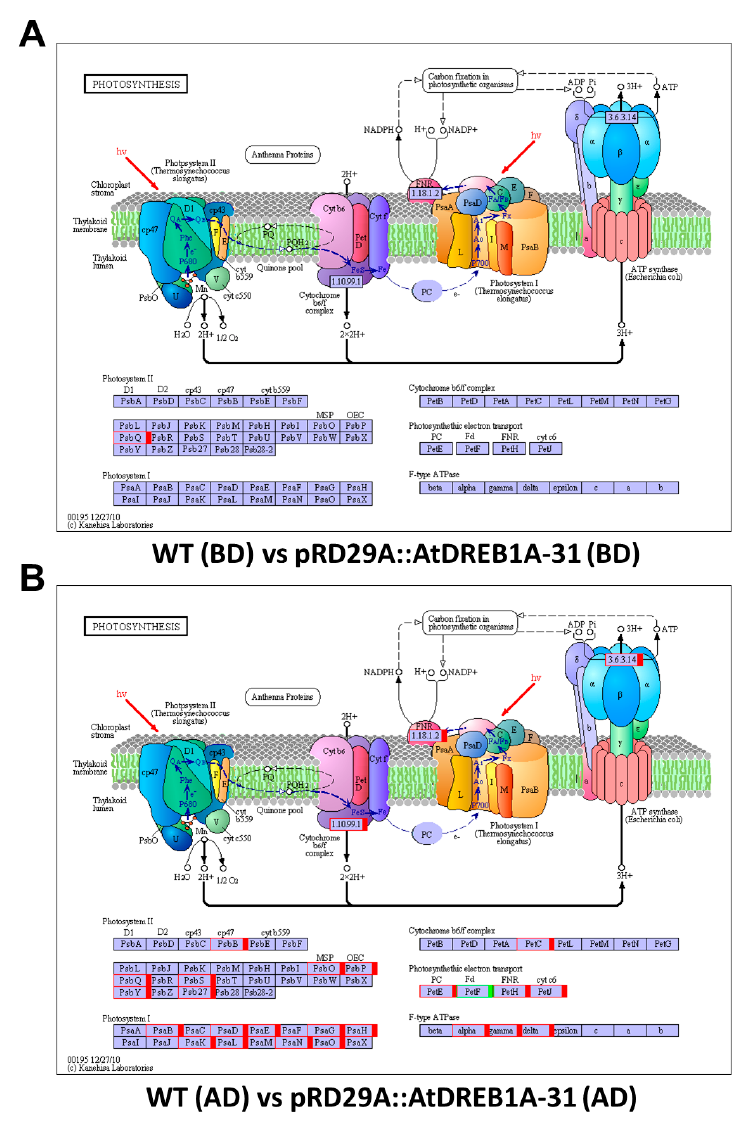
Figure 7. Analysis of DEGs related to photosynthesis in the comparisons of WT and AtDREB1A transgenic plants before and after drought treatment. ( A ) WT (BD) versus pRD29A::AtDREB1A-31 (BD); ( B ) WT (AD) versus pRD29A::AtDREB1A-31 (AD). Red/green indicate up- and down-regulated DEGs, respectively. Blue indicates DEGs with mixed patterns of regulation. WT, wild-type; pRD29A::AtDREB1A-31, pRD29A::AtDREB1A transgenic line 31. BD, before drought; AD, after six days of drought.